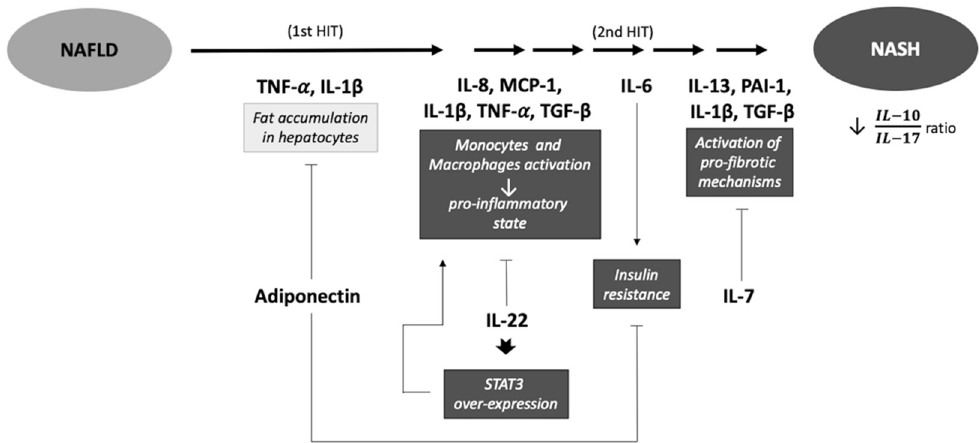
Figure 1. Pro- and anti-inflammatory cytokines involved in the physiopathology of NAFLD progression. IL-1 β promotes fat accumulation in hepatocytes and then, it induces liver inflammation and stimulates liver fibrosis in a late stage of the disease [21,31]; TGF- β performs the same function [29]. TNF- α mediates the early stage of NAFLD by fat accumulation in hepatocytes and also facilitates disease progression to a more advanced stage. IL-8 and MCP-1 activate monocytes and macrophages and attract polymorphonuclear leukocytes to the site of inflammation inducing a proinflammatory microenvironment [22,32]. IL-6 induces insulin resistance in hepatocytes [23]. IL-13 appears to activate distinct profibrotic mechanisms during the progression of NAFLD [24]. PAI-1 is a primary regulator of the fibrinolytic system in NASH [25]. A more accentuated proinflammatory stage in NASH patients is indicated by a decrease of the IL-10 / IL-17 ratio [26]. IL-7 is known to suppress expression of several molecules known to promote fibrosis and stimulates the expression of factors that protect against it [27]. Adiponectin regulates hepatic insulin resistance and is related to hepatic fat content [22,33]. IL-22 has a dual role in hepatic inflammation; this cytokine has a protective e ff ect against liver damage inducing hepatocyte repair, but it also has a proinflammatory and tumorigenic role in the liver because of the overexpression of STAT-3 induced by a successive induction of IL-22 [28,34]. NAFLD, nonalcoholic fatty liver disease; NASH, nonalcoholic steatohepatitis; IL-1 β , interleukin-1 β ; TNF- α , tumor necrosis factor- α ; IL-8, interleukin-8; MCP-1, monocyte chemoattractant protein-1; IL-6, interleukin-6; IL-13, interleukin-13; PAI-1, plasminogen activator inhibitor-1; IL-10, interleukin; IL-17, interleukin-17; IL-7, interleukin-7; IL-22, interleukin-22; TGF- β , transforming growth factor beta; STAT-3, signal transducer and activation of